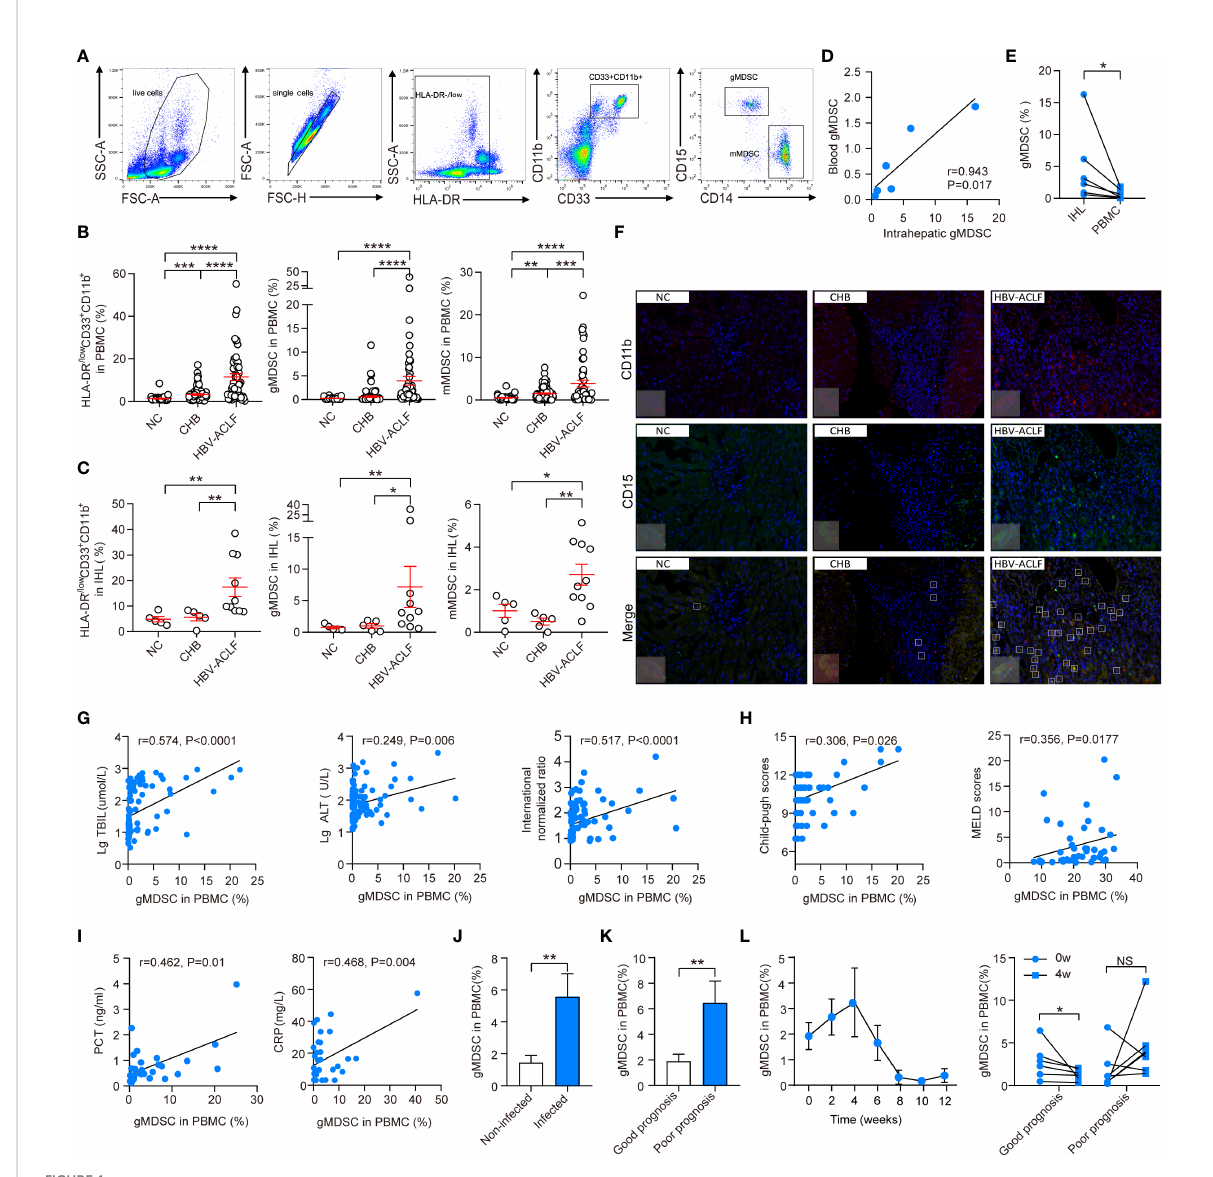
FIGURE 1 The proportion of gMDSC was correlated with disease progression, prognosis, and infectious complications in HBV-ACLF patients. (A) Sequential gating strategy for gMDSC (HLA-DR − /low CD33 + CD11b + CD14 − CD15 + ) and mMDSC (HLA-DR − /low CD33 + CD11b + CD14 + ) identi fi cation using fl ow cytometry from freshly isolated PBMCs. The proportion of gMDSC was calculated as a percentage of live PBMCs. (B, C) Cumulative dot plots of myeloid cells (HLA-DR − /low CD33 + CD11b + ); gMDSC and mMDSC in peripheral blood (B) and intrahepatic lymphocytes (C) . (D, E) Cumulative data depicting the relationship (D) and differences (E) between circulating and intrahepatic gMDSC. (F) Representative double epitope immunostaining of liver sections from HC, CHB, and HBV-ACLF participants for CD11b (red) and CD15 (green). Scale bar, 70×. (G-I) Correlation of circulating gMDSC proportion with biochemical indices of liver injury (G) , prognosis (H) , and in fl ammation (I) . (J, K) Histogram of gMDSC as a percentage of PBMCs, categorized by infection (J) and prognosis (K) in HBV-ACLF patients. (L) Changes in gMDSC during disease progression of HBV-ACLF patients. Error bars, mean ± SEM; one-way ANOVA followed by Fisher ’ s LSD multiple-comparison test (B, C) ; Mann – Whitney U test (J, K) ; Wilcoxon test (E, L) ; and Spearman tests (G-I) ; *P <.05, **P <.01, ***P <.001, and ****P <.0001. NS, no signi fi